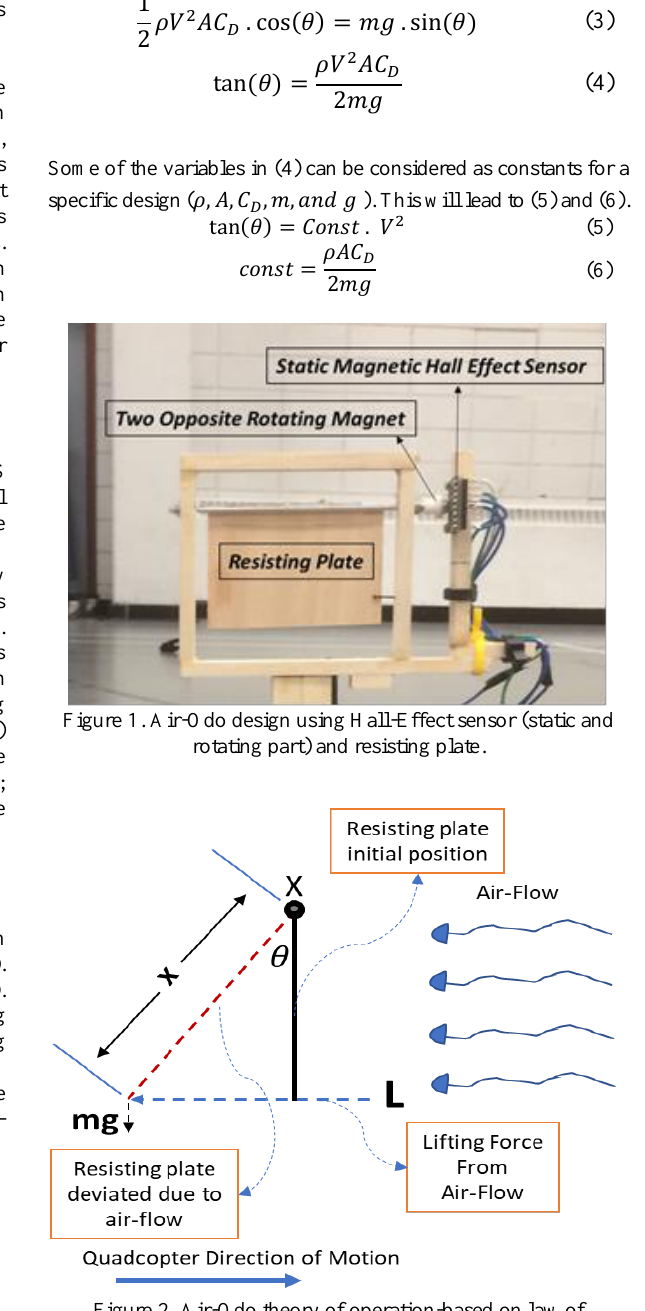
Figure 2. Air-Odo theory of operation-based on law of immersed bodies in fluid (lifting